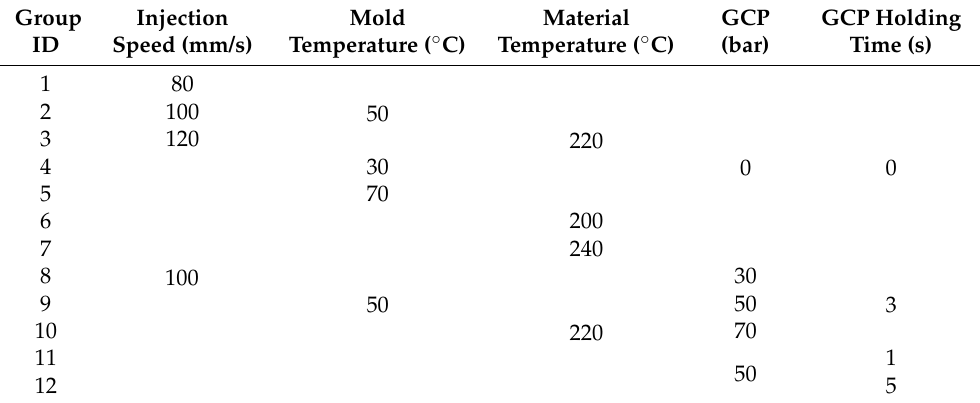
Table 1. Processing conditions for conventional injection molding (CIM) without (ID 1–7) and with gas counter pressure (GCP, ID 8–12).